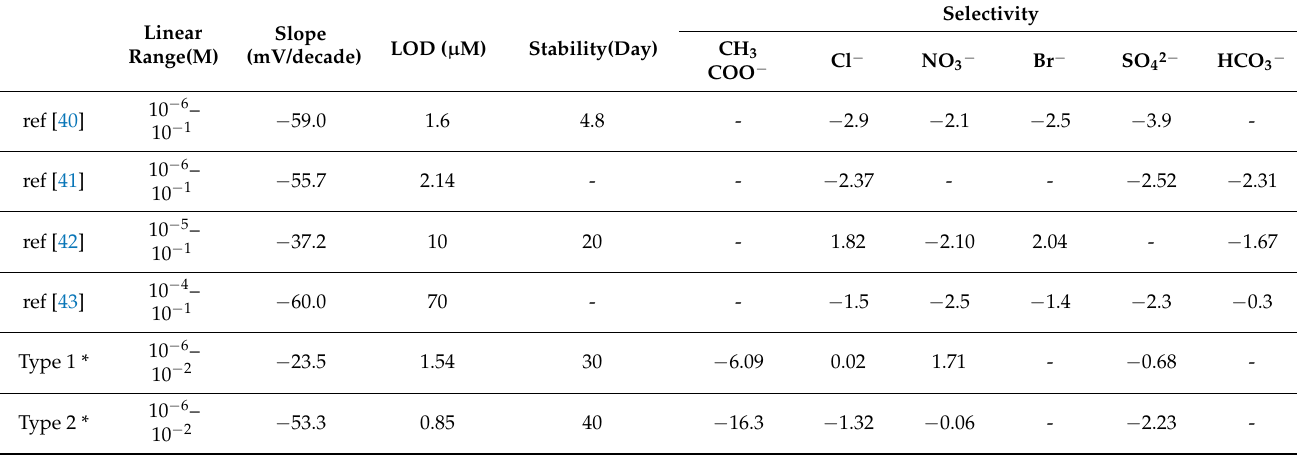
Table 1. Comparison of ISE characteristics of Type 1 and 2 with other research